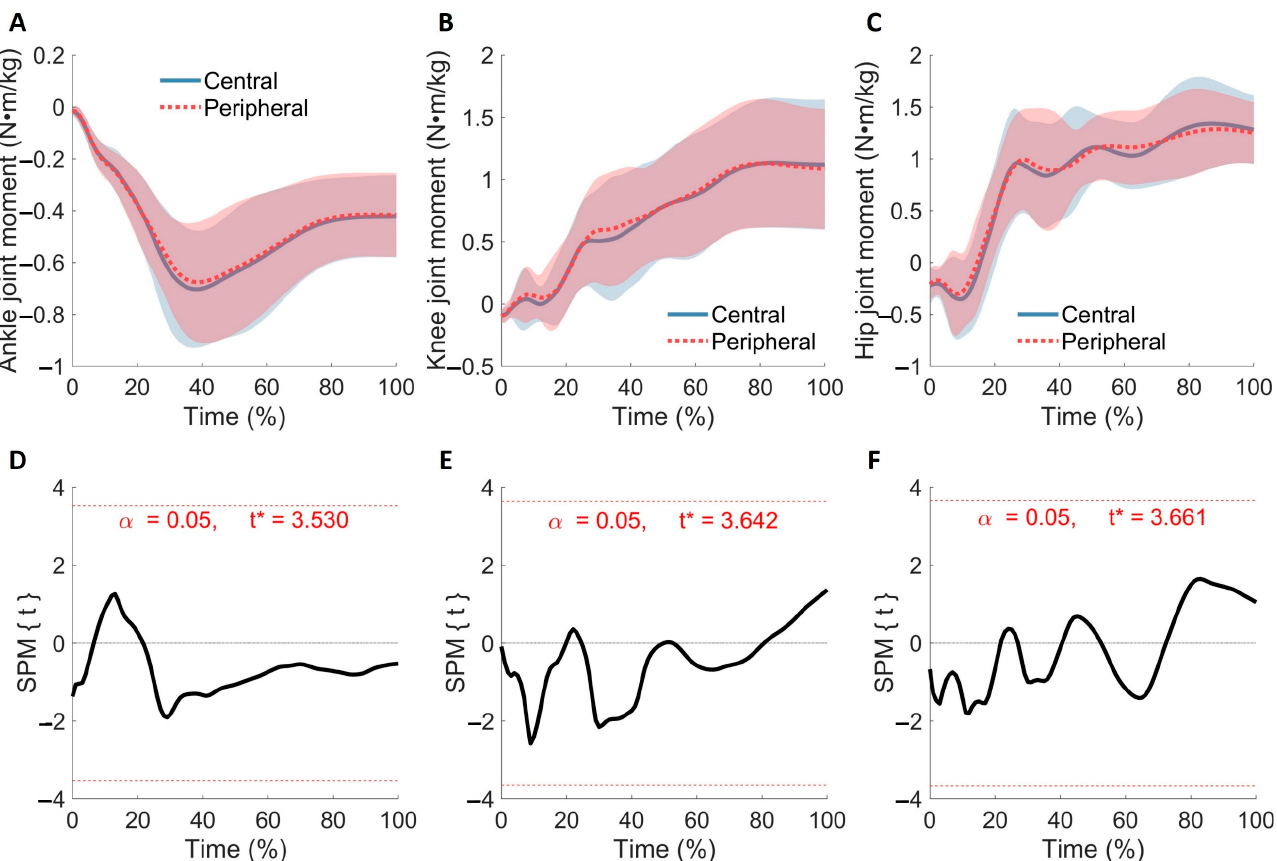
Figure 4. Frontal plane joint moment. Descriptive statistics for each condition (mean ± 1 standard deviation error cloud) for the ankle ( A ), knee ( B ), and hip ( C ) joint moments. Time was determined from initial contact (0%) to peak knee flexion (100%). The black line is the t-value of each time point for the ankle ( D ), knee ( E ), and hip ( F ) joint moment. The dotted redline is the threshold of significance. No significant difference was observed in the frontal plane joint moment between the landing